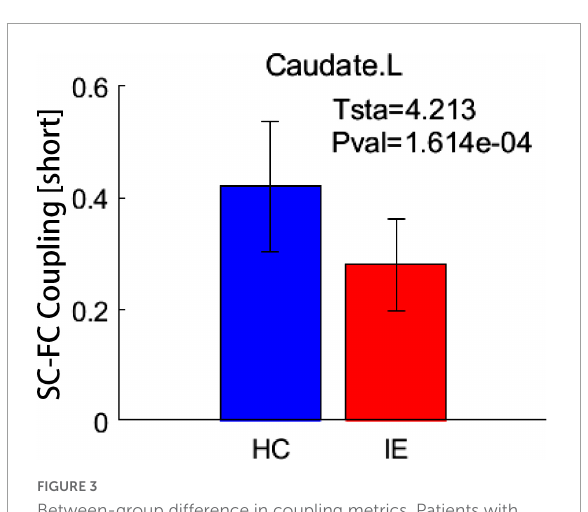
FIGURE3 Between-group difference in coupling metrics. Patients with infantile esotropia exhibited attenuated coupling score for short connections in left caudate nucleus relative to healthy subjects ( P < 0.05, FDR corrected). The whisker represents the standard deviation of the mean. SC, structural connectivity; FC, functional connectivity; HC, healthy control; IE, infantile esotropia; L, left.